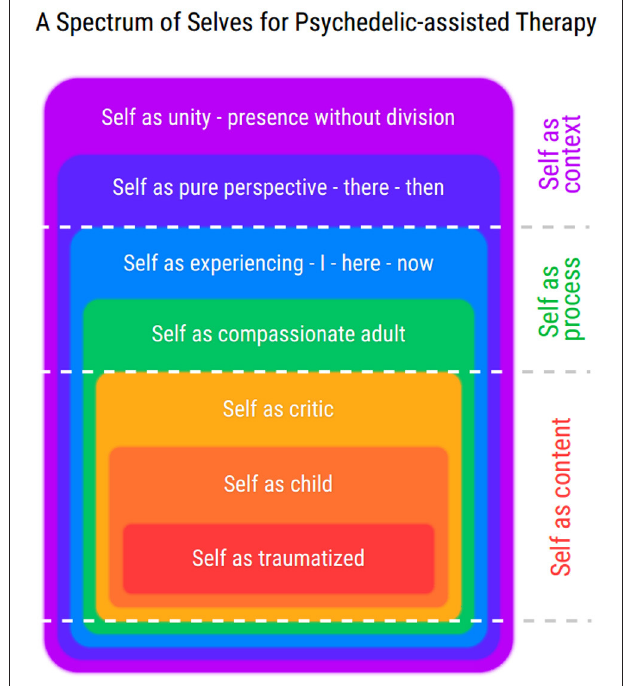
FIGURE 2 | First presented at Association of Contextual Behavioural Science conference, New Orleans (Online) 2020. Reprinted with permission. These multiple selves are framed as concentric circles like Russian dolls. The varying selves are arranged according to how psychologically flexible they are. The blurred edges of each self represent the fact that self-experiences are never fully captured by language or explicit cognition, and that implicit, unseen aspects are always part of the equation. For an expanded version of this model’s axes, see Table 2